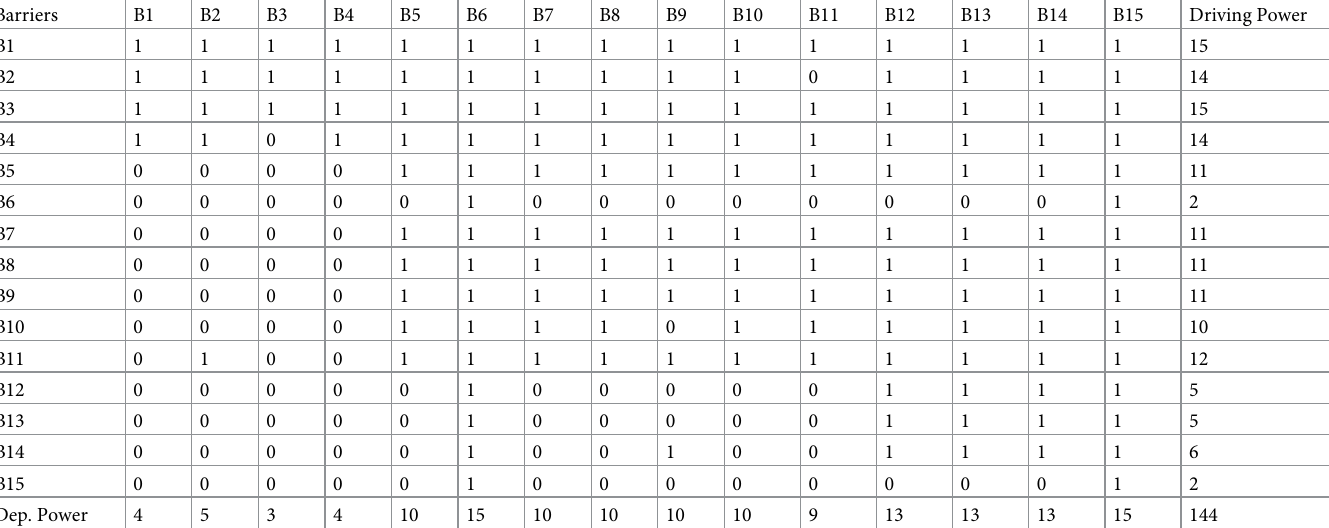
Table 7. Initial reachability matrix.